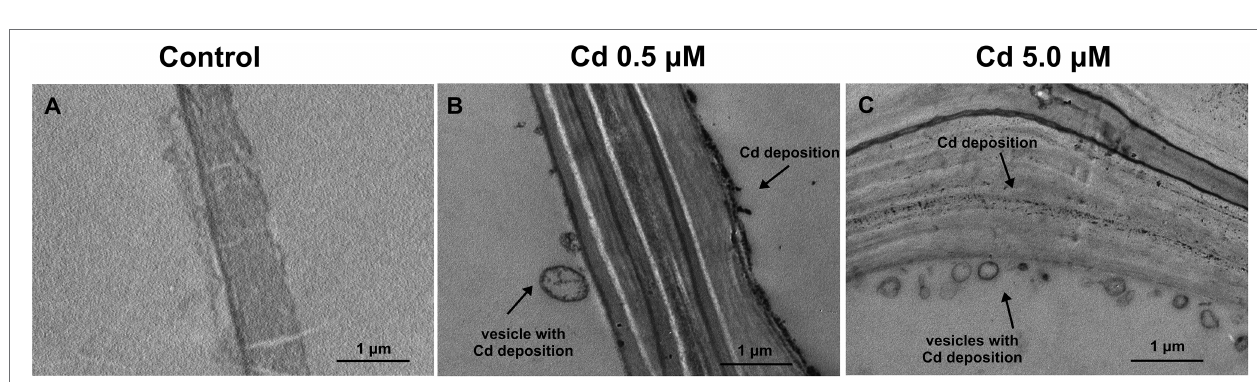
FIGURE 7 | Transmission electron micrographs of root cortical cells (15 days from sprouting and from the start of Cd treatments). Panel (A) Control roots; panel (B) roots treated with Cd 0.5 μ M; panel (C) roots treated with Cd 5.0 μ